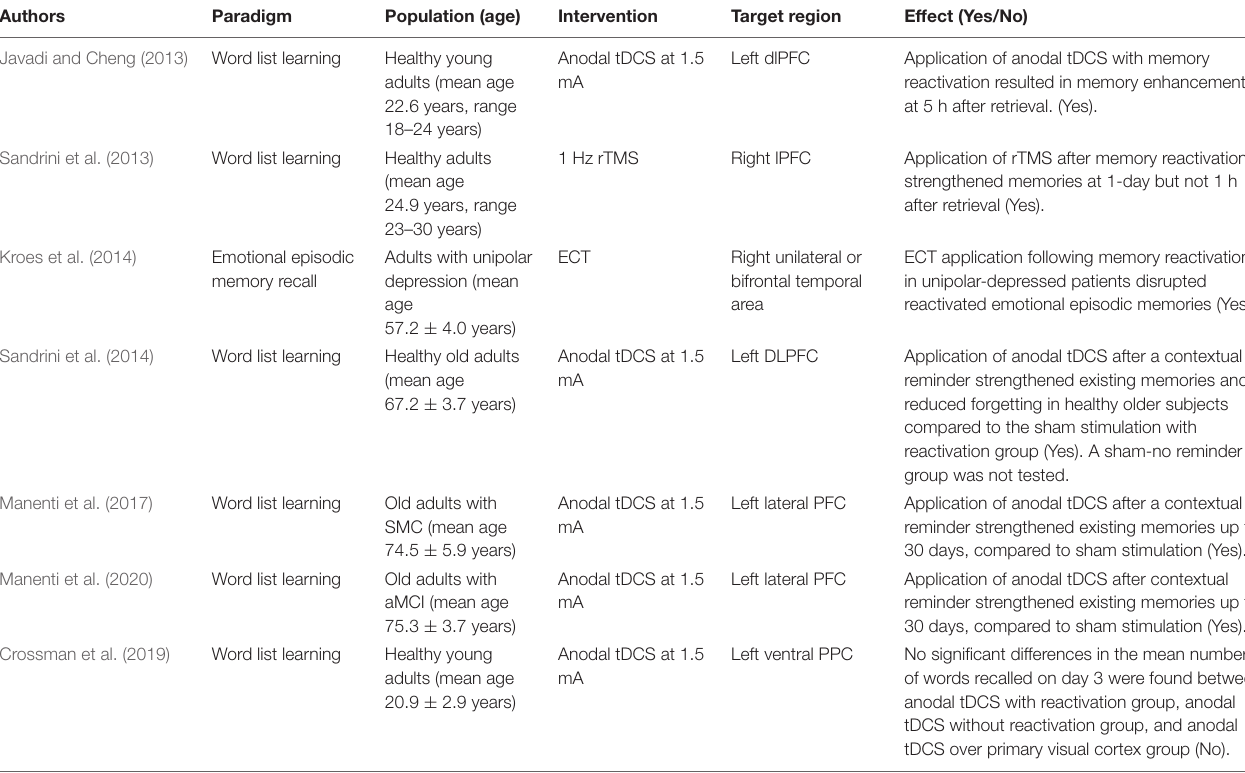
TABLE 1 | Recent human reconsolidation studies of declarative memory using brain stimulation as an intervention